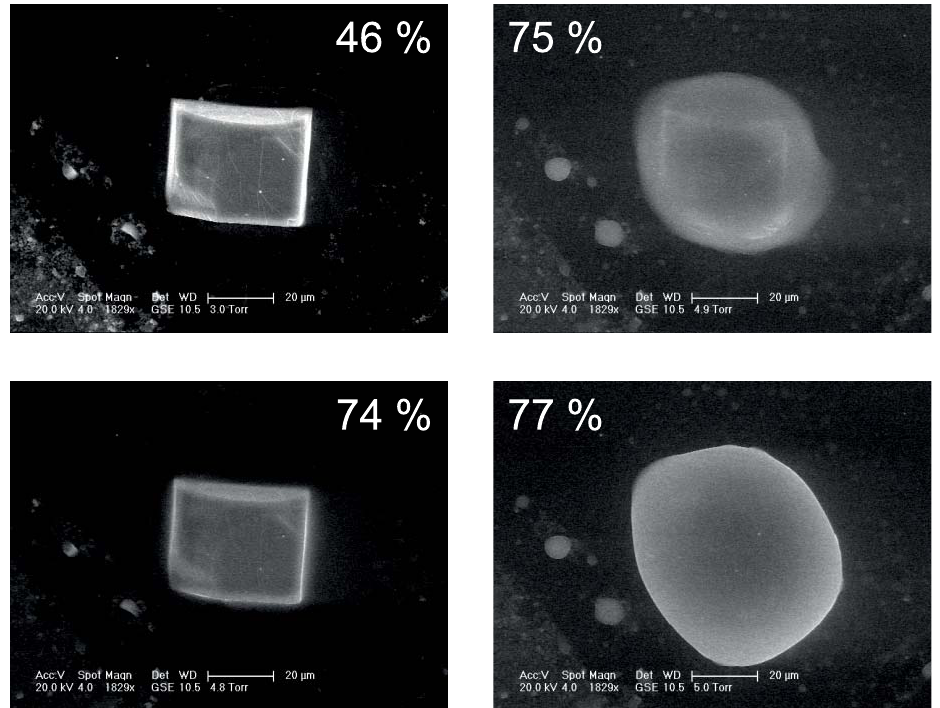
Figure 1. Sodium chloride deliquescence at 75% RH observed at laboratory conditions (at 4.9 ◦ C) in an environmental scanning electron microscope. The dry cubic particle with sharp edges at RH of 46% becomes surrounded by a liquid sphere when RH increases to